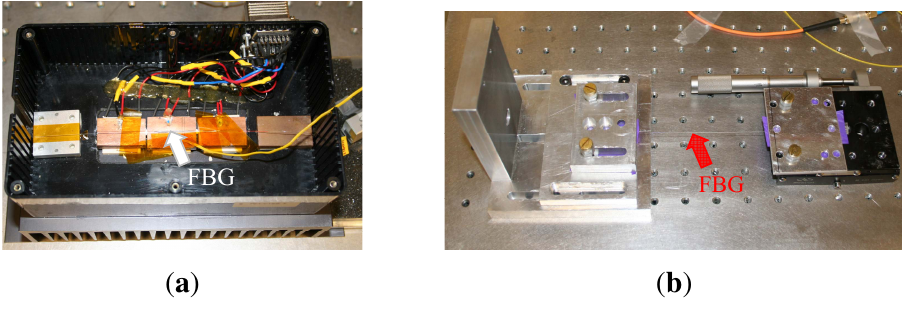
Figure 12. Fully embedded system tests. ( a ) Temperature characterization set-up; ( b ) Axial strain characterization set-up.